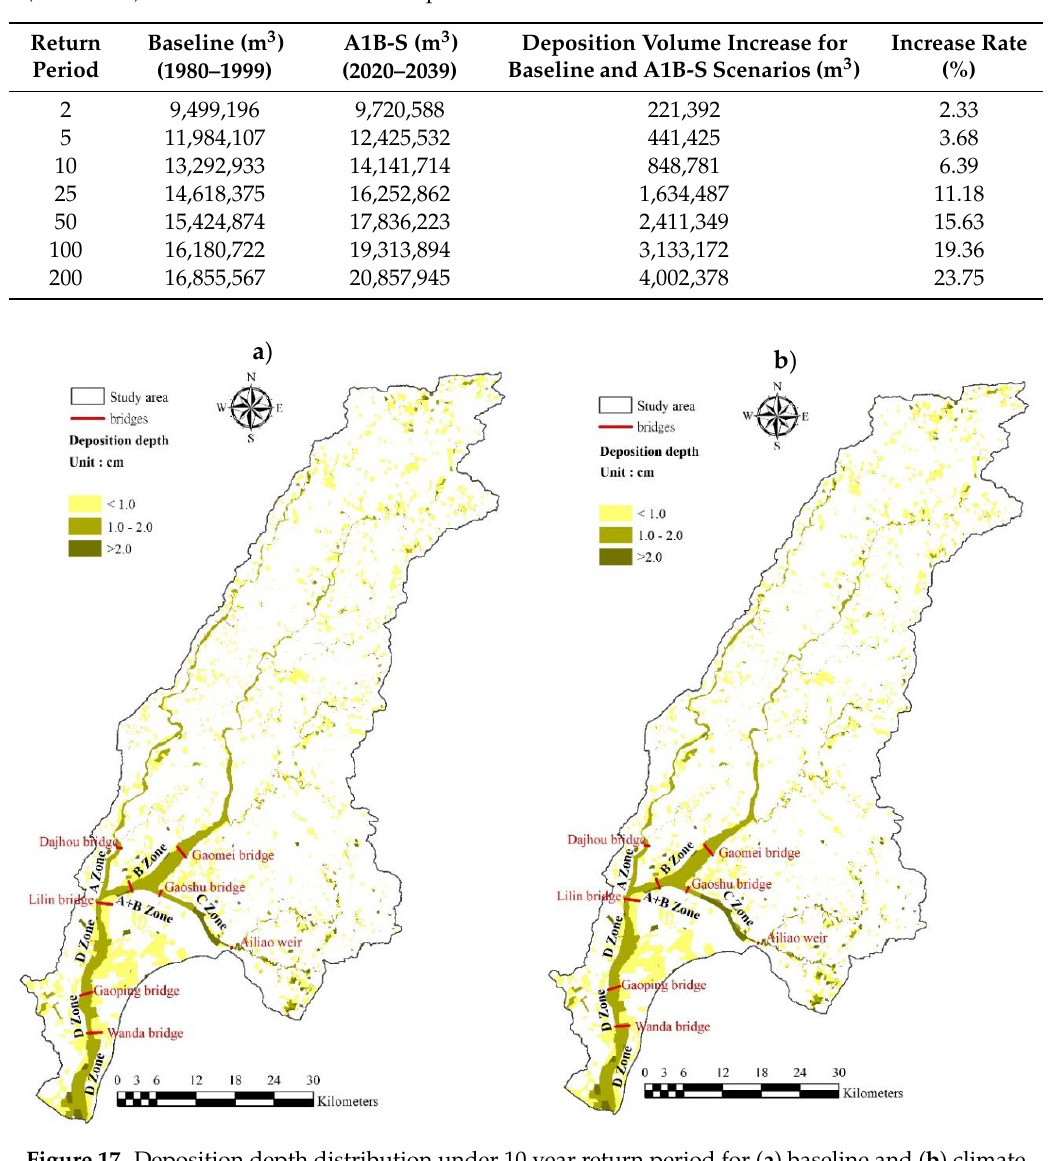
Figure 17. Deposition depth distribution under 10 year return period for ( a ) baseline and ( b ) climate change scenarios.